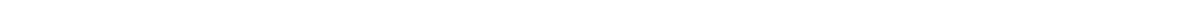
Fig. 1 Distinct chromatin states of human PDAC PDTXs. a Chromatin state de fi nitions and histone mark probabilities as determined by ChromHMM 8 . Average genome coverage. Genomic annotation enrichments for each chromatin state as calculated by ChromHMM. b Boxplots illustrate sample centered averaged gene expression of genes within regions of particular chromatin states based on RNA-seq data. c Boxplots depict sample-averaged level of DNA methylation for the overlapping CpGs with each chromatin state. Dotted line represents mean methylation cut-off (0.5). d Gene-set enrichment analysis (GSEA) pathways for each chromatin state. Circle size is proportional to − log 10 p -value (showing only p -value < 5%) and colors correspond to the mean normalized expression of the genes driving the enrichment, or leading-edge genes. e Heatmap of the frequency of each state among all samples for tumor suppressors (green labels), pro-tumorigenic genes (red labels), and epigenetic regulators (blue labels). Boxplots of gene expression and methylation level are shown for each gene. f , g Visualization of chromatin state proportions on all samples and methylation levels across the SOX9 locus and the SMO locus. Stacked bars represent the proportion of each chromatin state at a given genomic position. Methylation level is represented for each sample, at each genomic position and colored by its value. For all boxplots ( b , c , e ), bottom and top of boxes are the fi rst and third quartiles of the data, respectively, and whiskers represent the lowest (respectively highest) data point still within 1.5 interquartile range of the lower (respectively upper) quartile. Center line represents the median